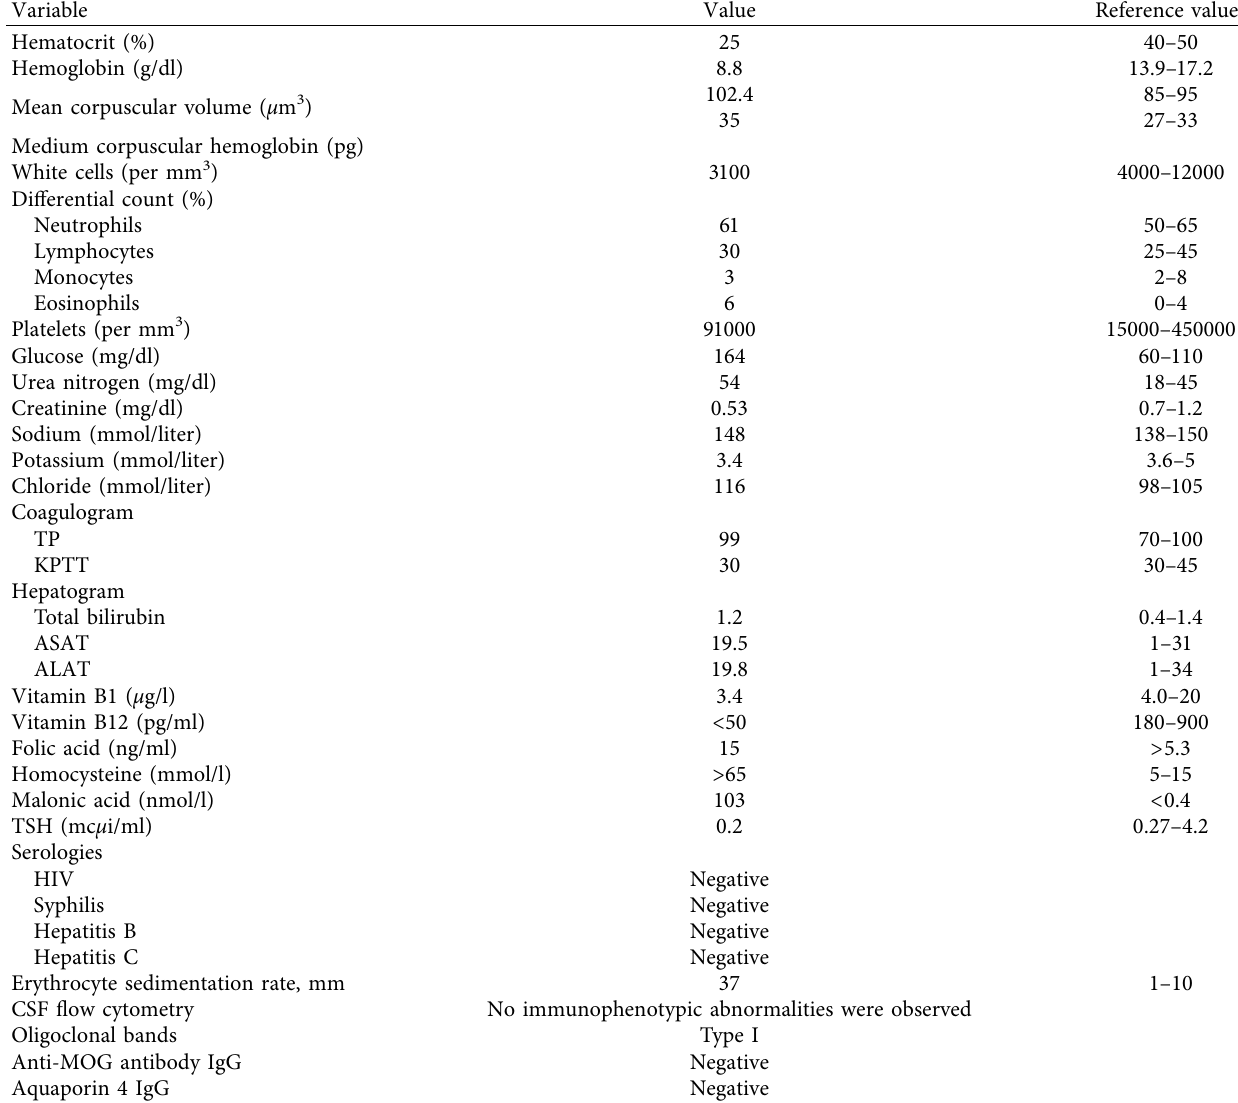
Table 1: Blood chemical